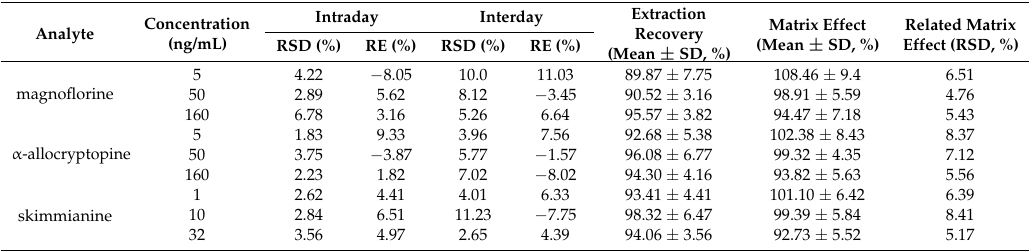
Table 3. Precision, accuracy, extraction recovery and matrix effect of analytes in rat plasma ( n = 6).